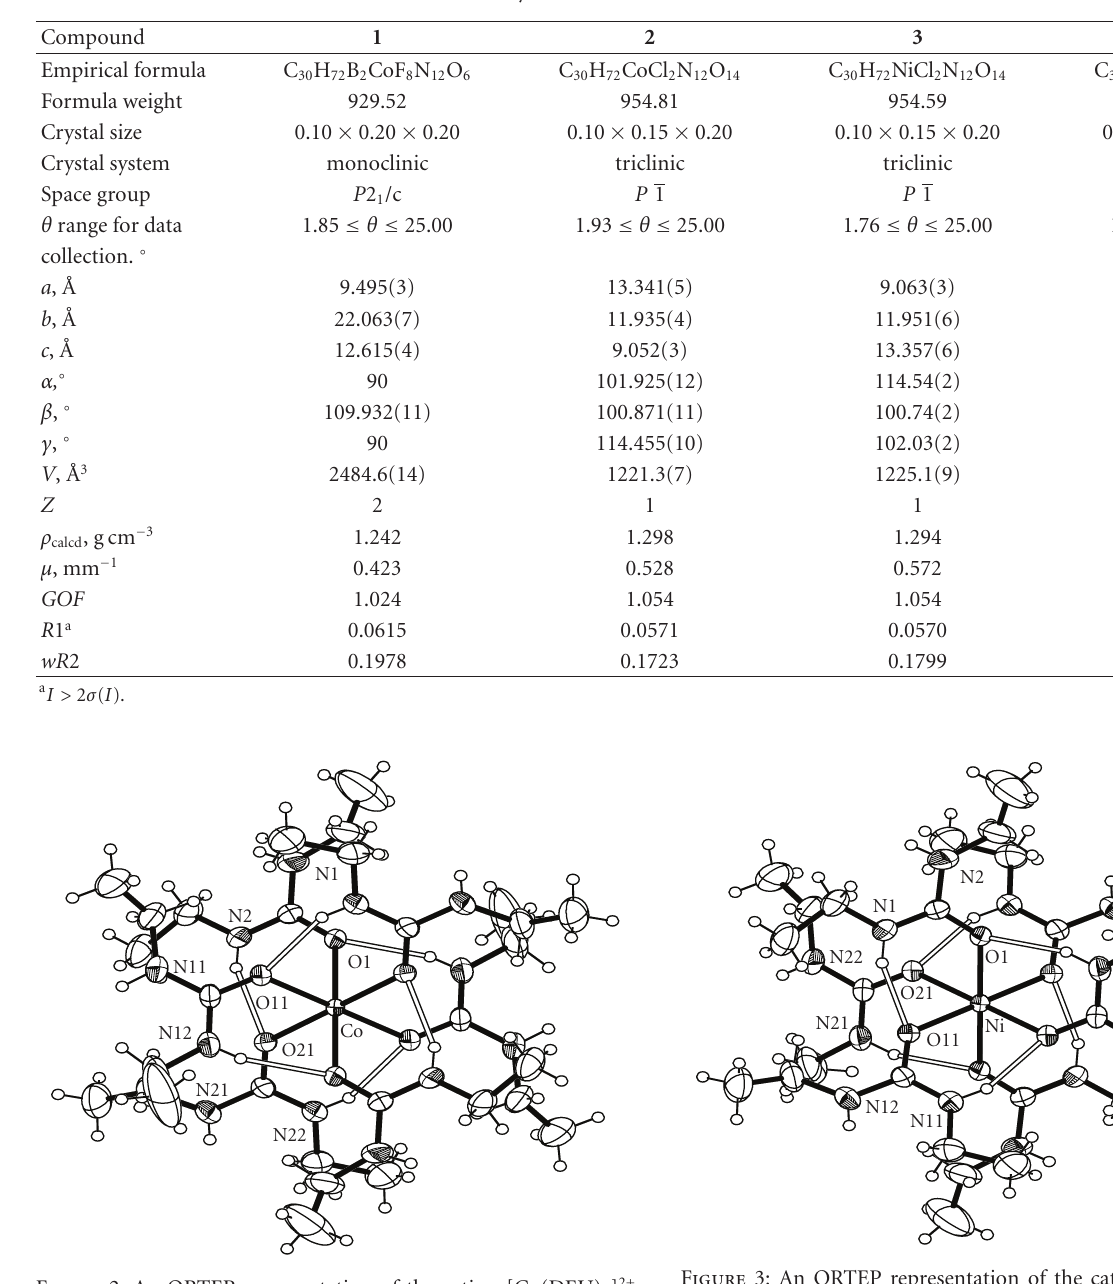
Figure 2: An ORTEP representation of the cation [Co(DEU) 6 ] 2+ present in complex 2 . Open bonds indicate intramolecular hydro- gen bonds. The symmetry-equivalent atoms are not labeled.